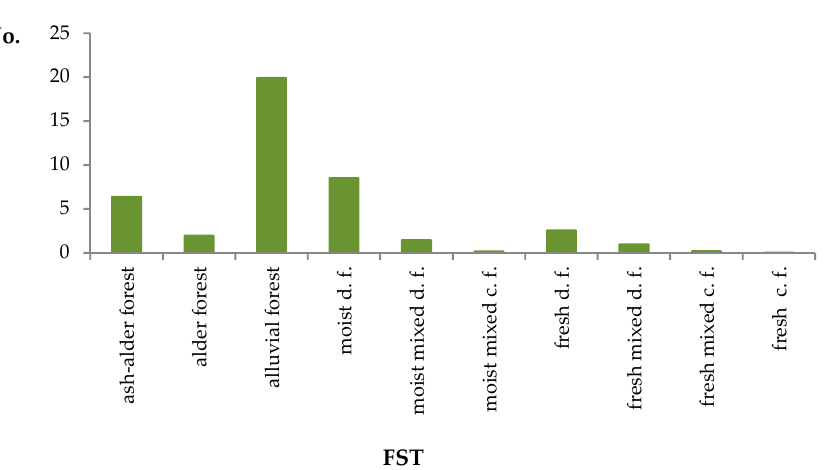
Figure 3. Number of forest plots with elms per 1 km 2 of total wooded area in forest sites of various types (FST). c.f.—coniferous forest, d.f.—deciduous forest.